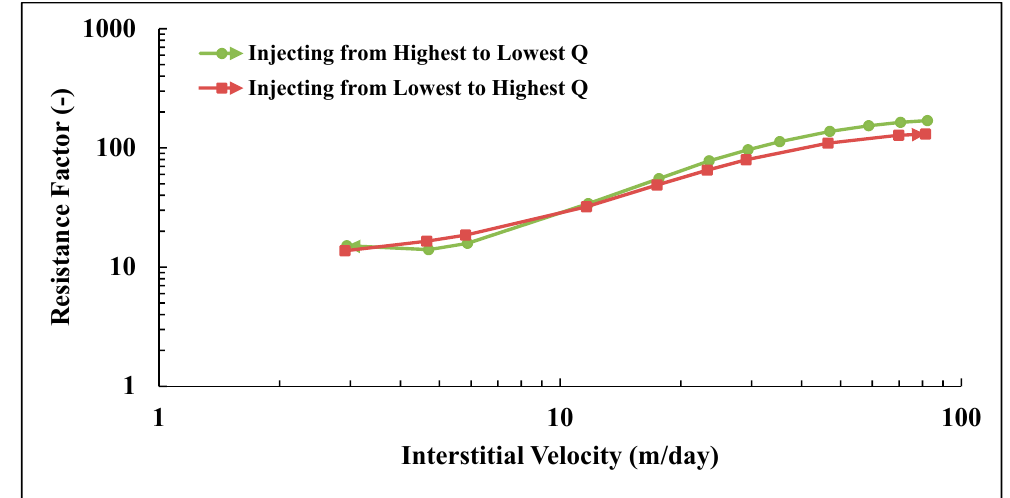
Figure 6. Resistance factor versus interstitial velocity for pre-sheared Solution A. The polymer was sheared at Q = 12 cc/min and RF measured at different injection schemes. Table 2. Properties of cores used for hysteresis investigation of polymer injection scheme.